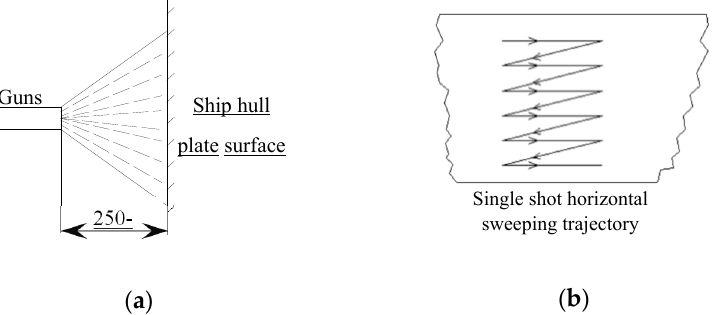
plate surface in the dock are shown in Figure 4.